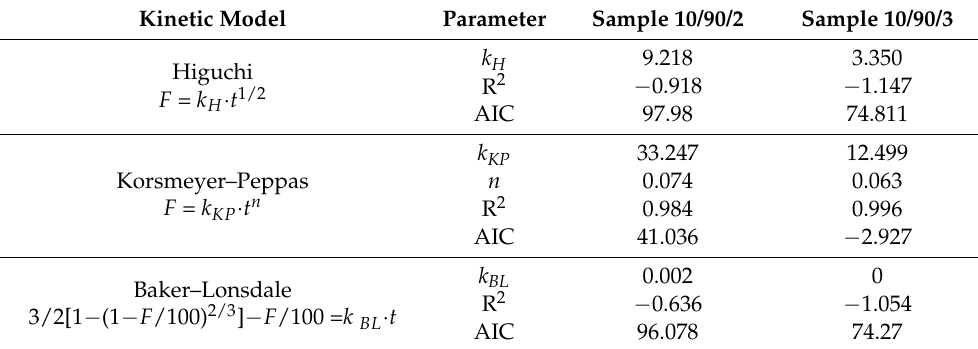
Table 5. The kinetic of curcumin release from p(NiPMAm/NiPAm)